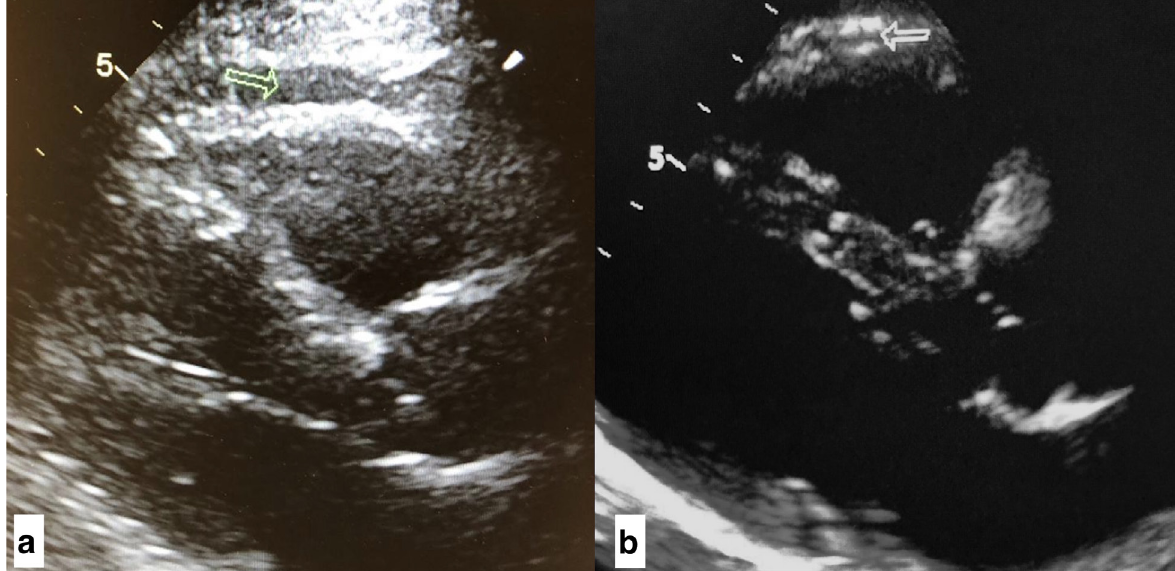
Figure 2. Measurement of Epicardial fat thickness in a patient who has diabetes mellitus disease (Figure 2a), and in a control subject (Figure 2b). Epicardial fat thickness (EFT) perpendicular to right ventricular free wall (arrow). EFT- identified as an echo-free space between the myocardium and visceral pericardium from the parasternal long-axis view on two-dimensional echocardiography, was measured perpendicularly in front of the right ventricular free wall at